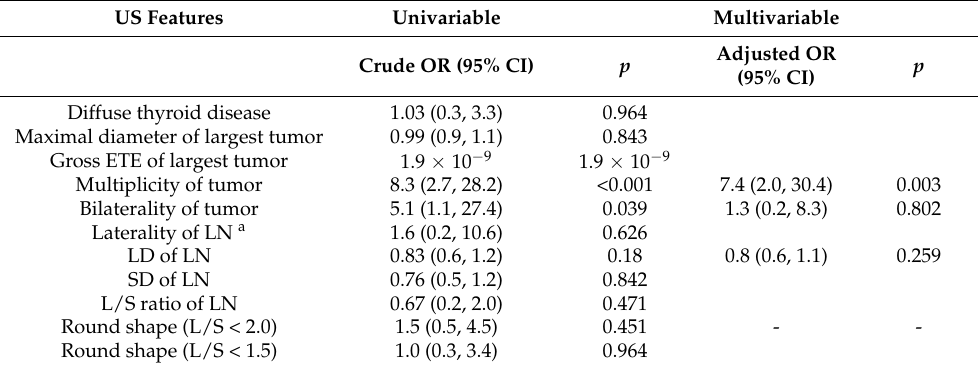
Table 5. Association of nodal size, shape parameters, and primary tumor characteristics with malignant LNs in US indeterminate